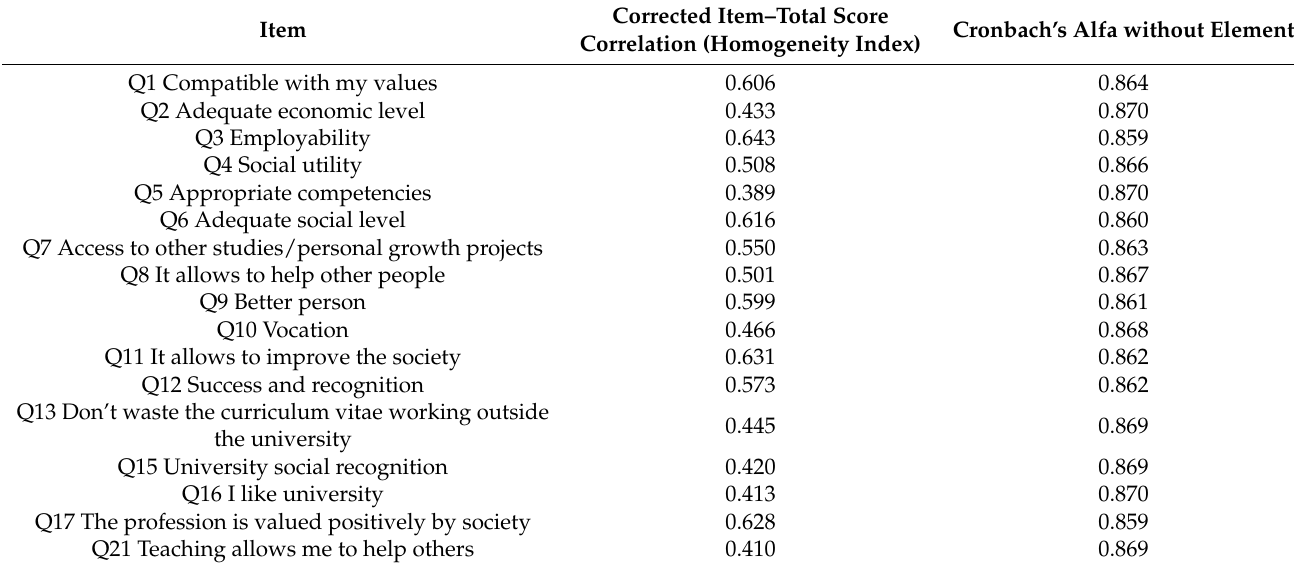
Table 3. Item–Total score statistics.